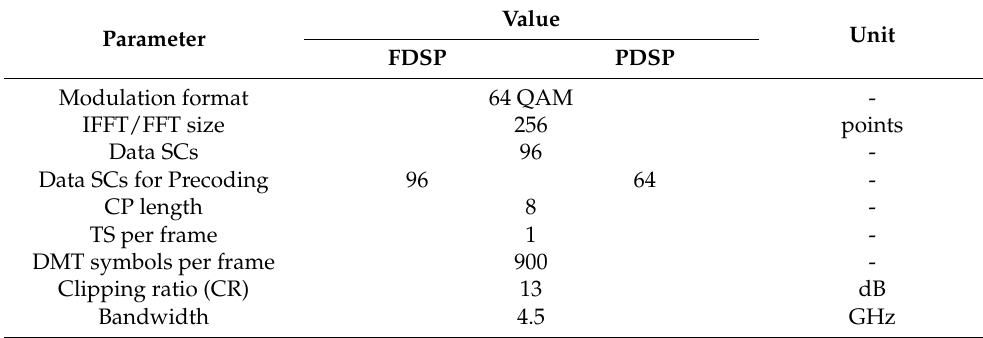
Table 2. Some key parameters of the precoded PS-DMT frame.